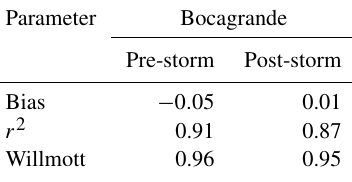
Table 3. SWAN error parameters for Bocagrande (Cueto and Otero,